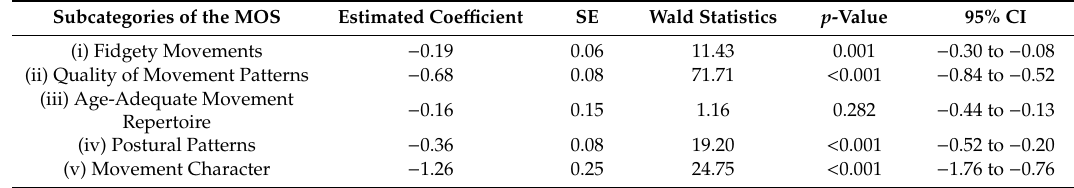
Table 3. Parameter estimates for the ordered logit model. Estimated coe ffi cients, standard errors (SE), Wald statistics, p -values, and 95% confidence intervals (CI) for the five motor optimality score (MOS)